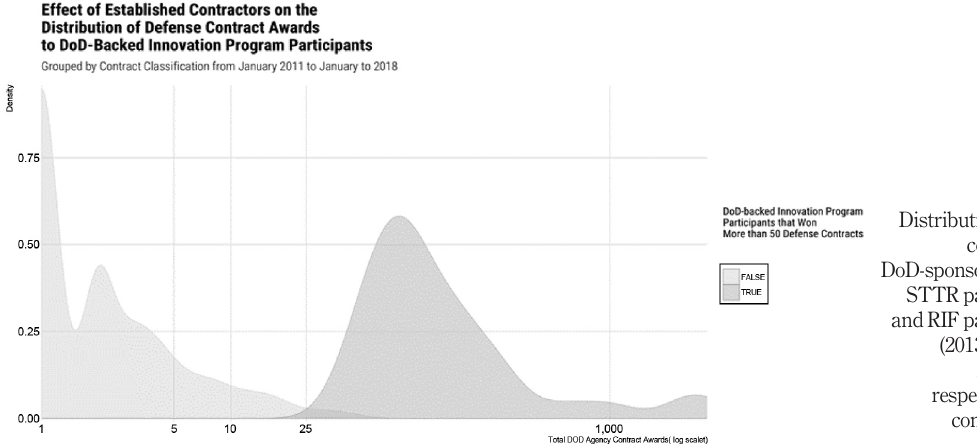
Figure 5. Distribution of